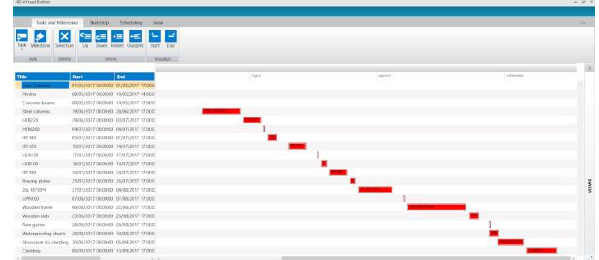
Figure 9. The Gantt chart in Sketchup via 4D Virtual Builder